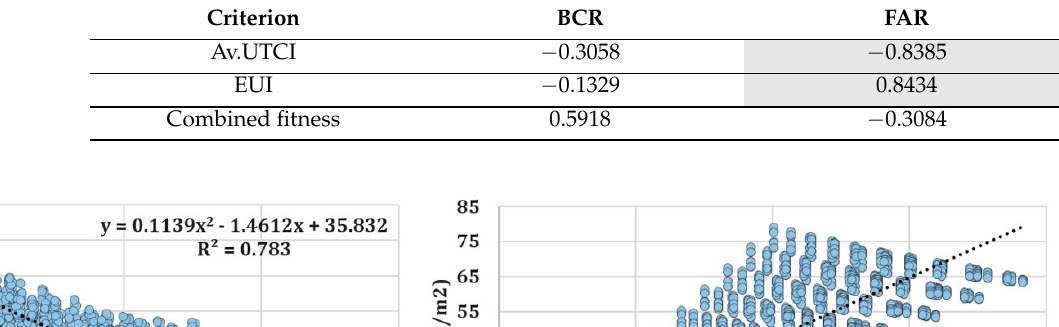
Table 4. Correlation coefficients (R) between density parameters and performance Criteria. The strongest correlations are highlighted.